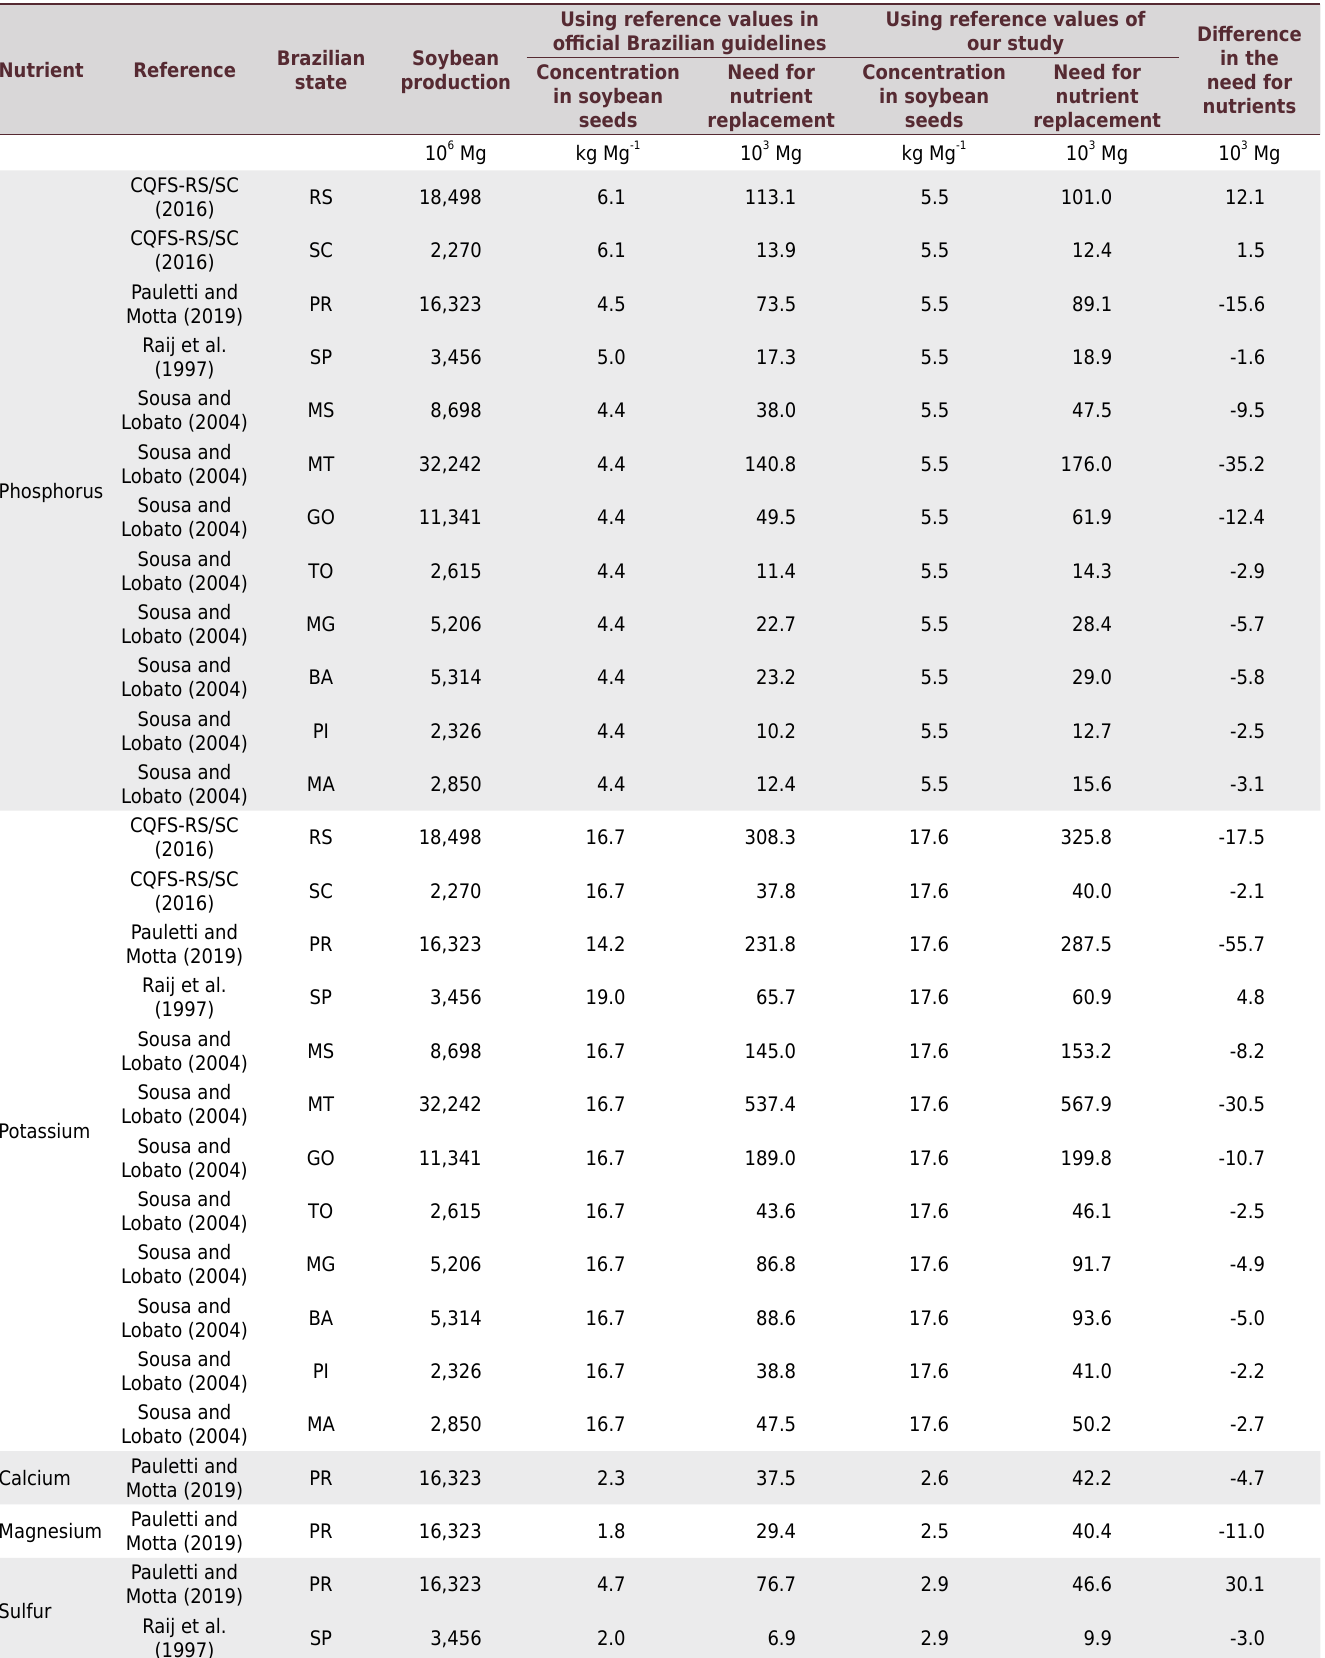
Table 2. Difference between the need for replacement fertilization of P, K, Ca, Mg and S in the main soybean producing states of Brazil considering the reference values in official Brazilian guidelines and the suggested recommendation considering the updated values of macronutrient concentration in soybean seeds obtained in the present study for the period between 2015 and 2019